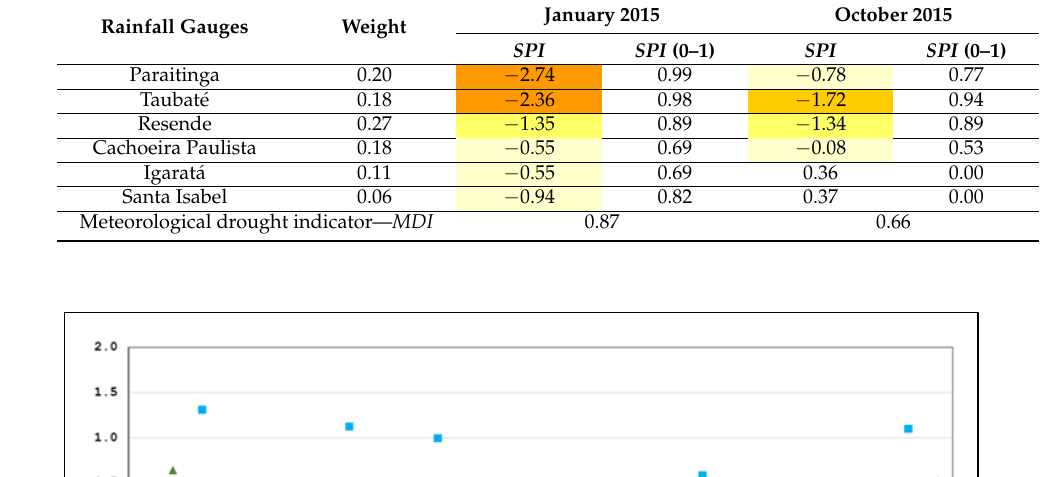
Table 8. Meteorological drought indicator (MDI ) application.